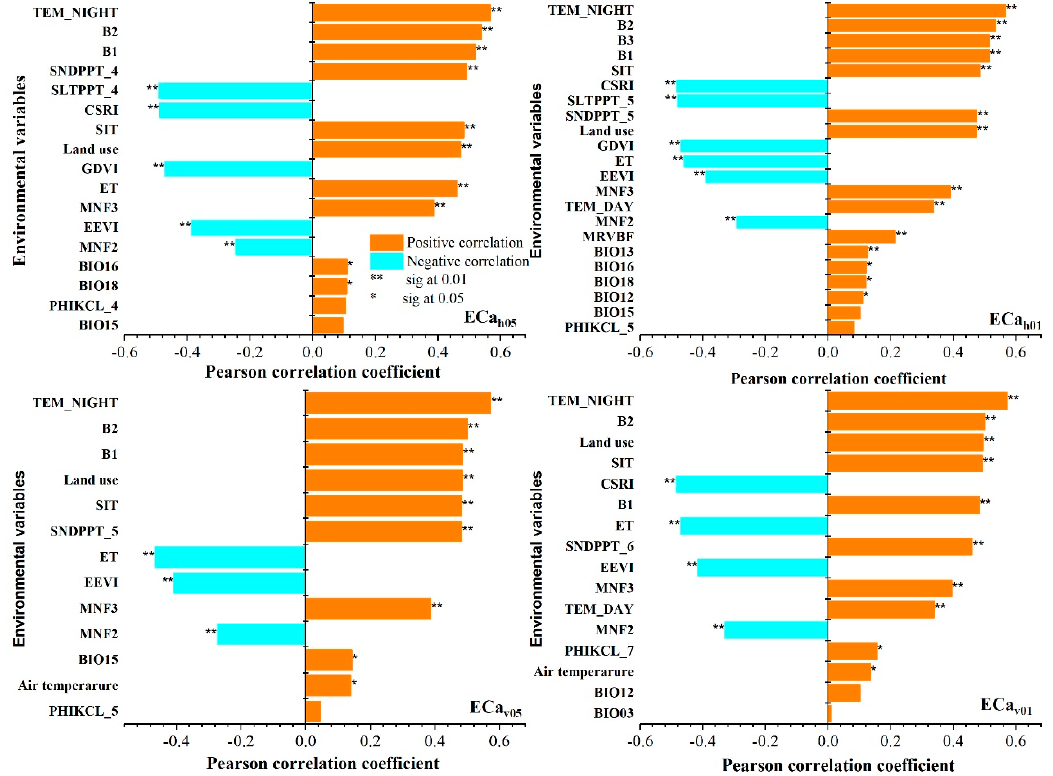
Figure 4. Correlation coefficients between environmental variables and measured ECa values. The RF algorithm showed the highest performance in the RFE selection; the most important variables were selected for each EMI coil configuration.